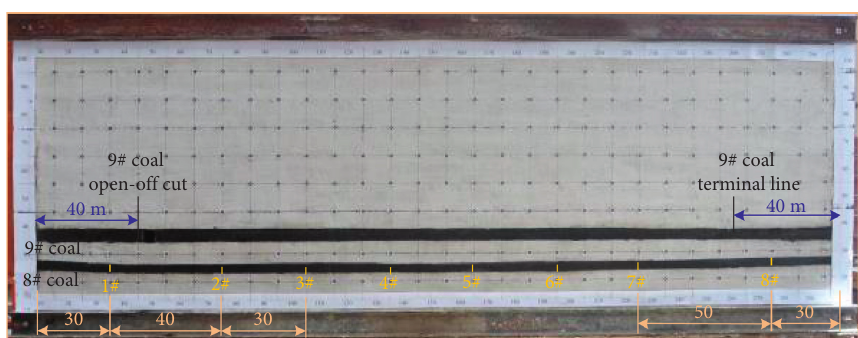
Figure 20: Unexcavated model diagram of similar simulation test.